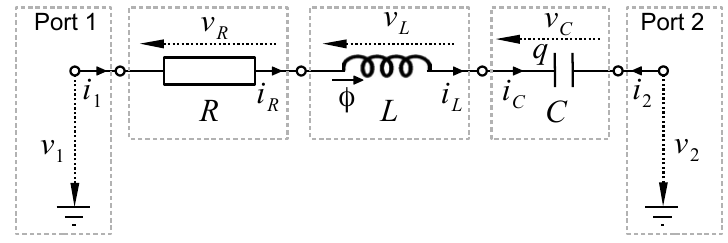
Figure 1. Resistor-inductor-capacitor (RLC) circuit (notations and